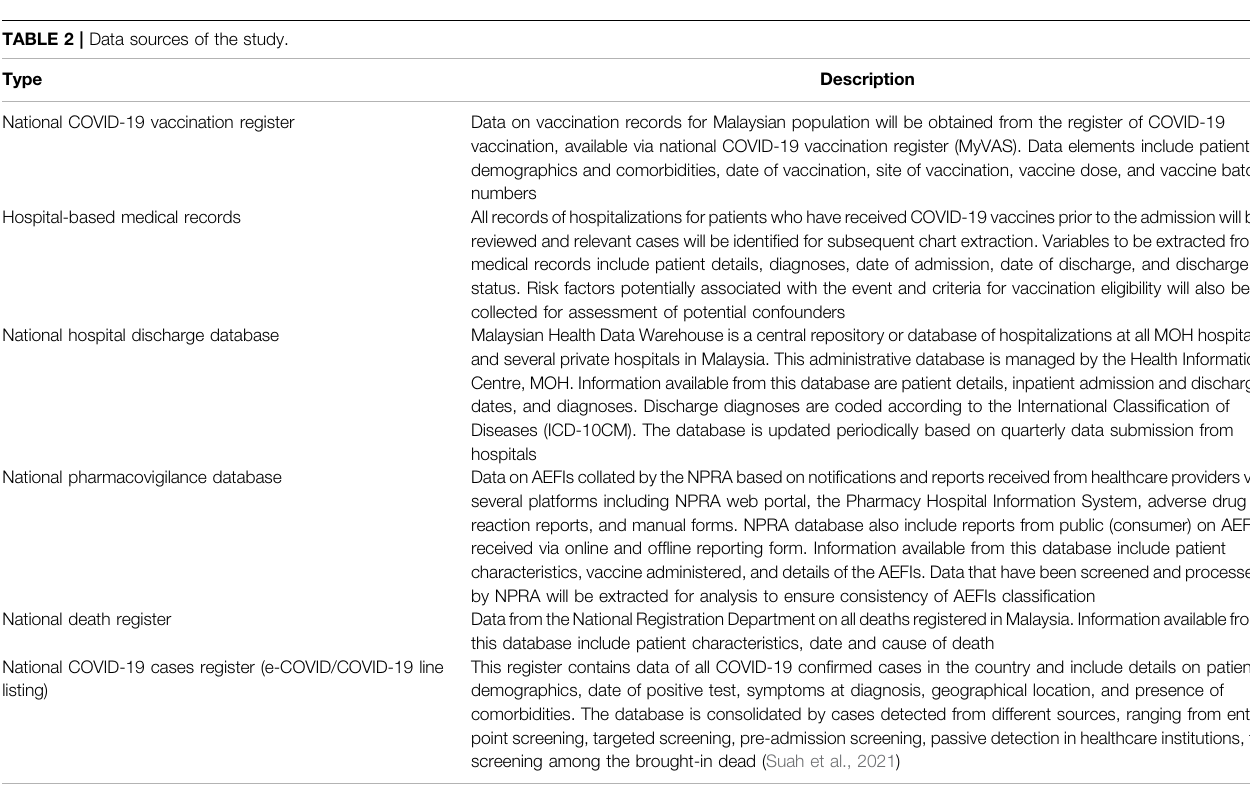
TABLE 2 | Data sources of the